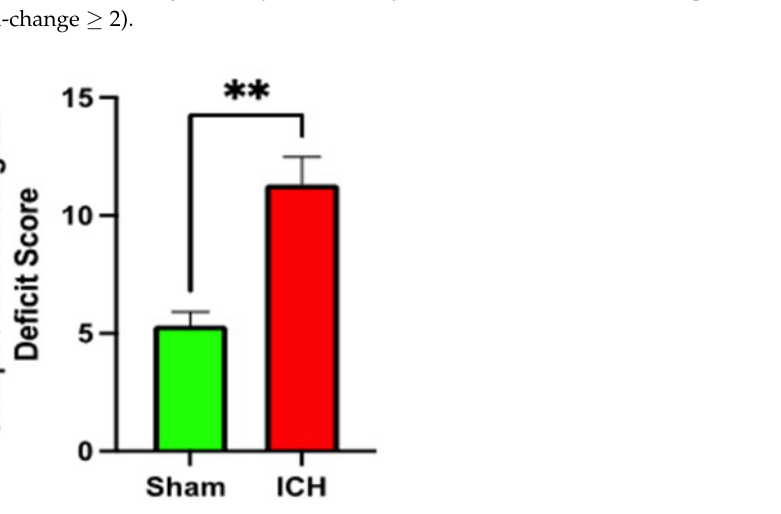
Figure 4. Induction of ICH in aged, male C57BL/6 (18–24 months) mice resulted in significant neurological deficits in comparison to sham. This was estimated using a 24-point scale, as described in methods, on day 1 post-surgery ( n = 3 animals per group ** p < 0.01 vs.